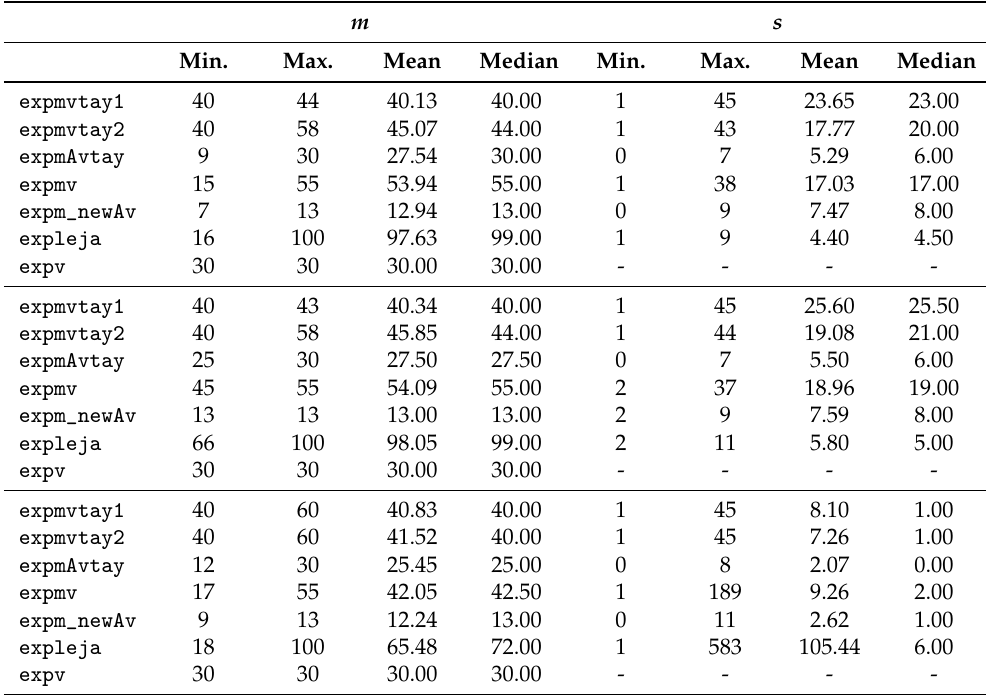
Table 4. Minimum, maximum, mean, and median parameters m and s employed for Sets 1, 2, and 3, respectively.